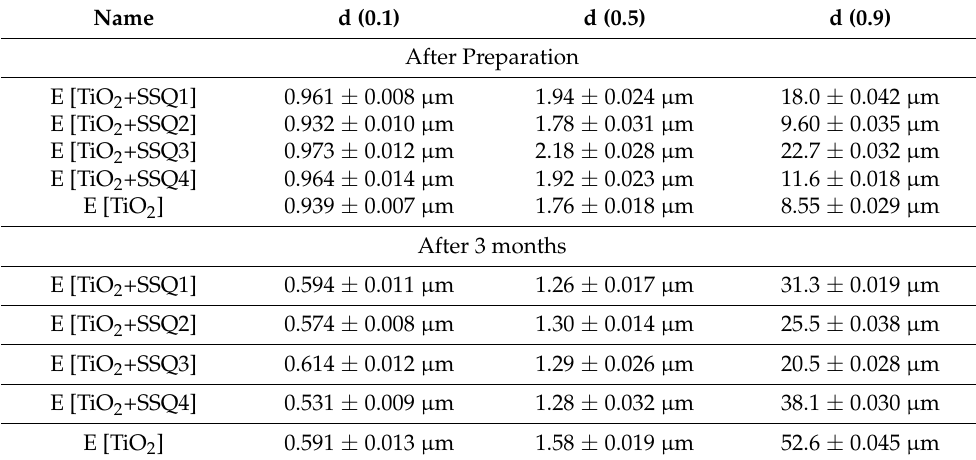
Table 6. Particle size distribution for